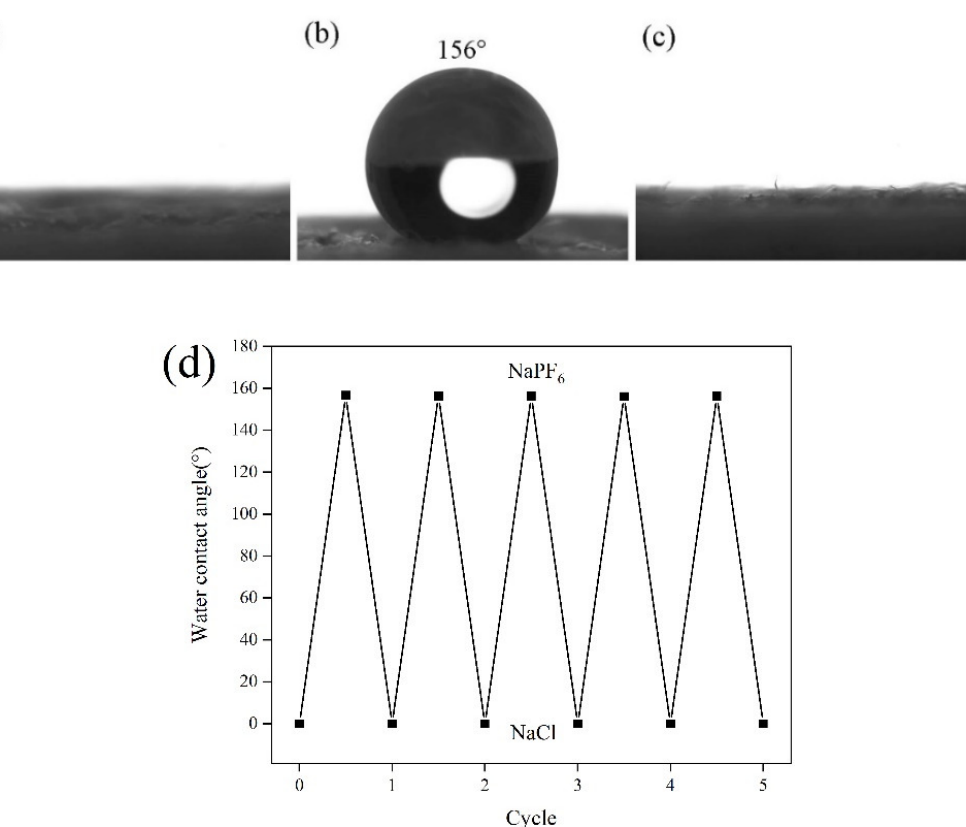
Figure 5. Contact angle of ( a ) Modified paper; ( b ) Modified paper after soaking in NaPF 6 ; ( c ) Modified paper after soaking in NaCl solution; ( d ) Modified paper after soaking in NaPF 6 and NaCl solutions .